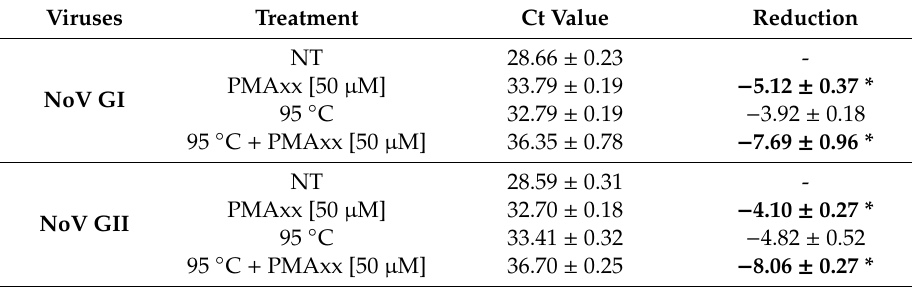
Table 1. Results of real time RT-PCR for norovirus (NoV) genotypes I and II (GI and GII) detection after di ff erent treatment. Table explanation: The significant values for method validation are as follows: The first value of reduction rate ( − 5.12) refers to the NoV GI treated only with PMAxx compared with the non-treated NoV GI; the third value of reduction rate ( − 7.69) refers to the NoV GI treated with PMAxx and high temperature compared with the non-treated NoV GI. In the same way, it is possible observe a reduction rate of − 4.10 between NoV GII treated with only PMAxx and the non-treated NoV GII and a reduction rate of − 8.06 between NoV GII treated with PMAxx and high temperature and the non-treated NoV GII.